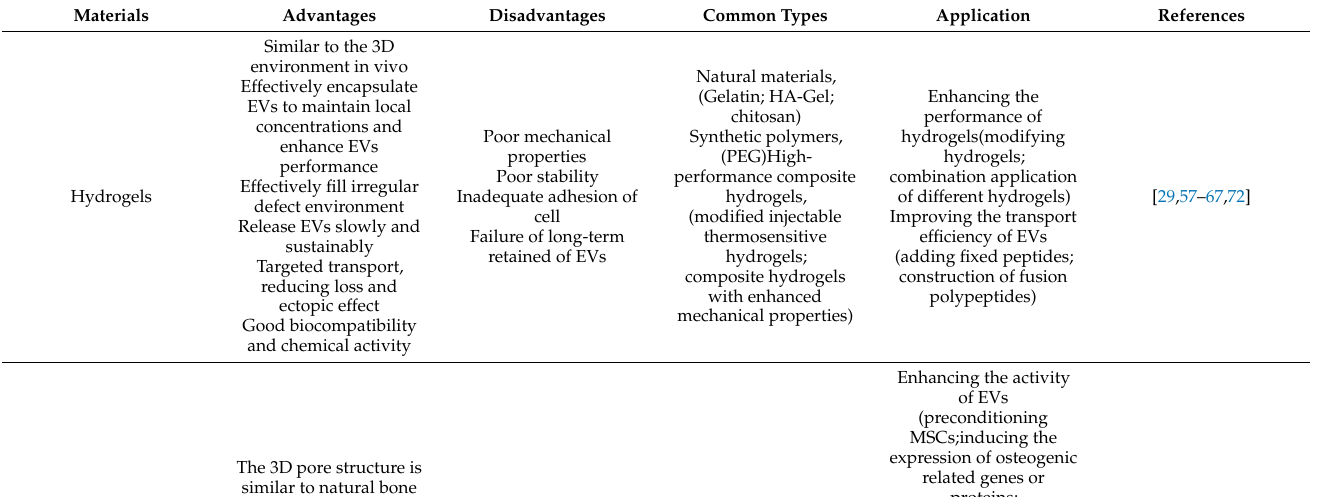
Table 2. Summary of the application of different carrier materials in